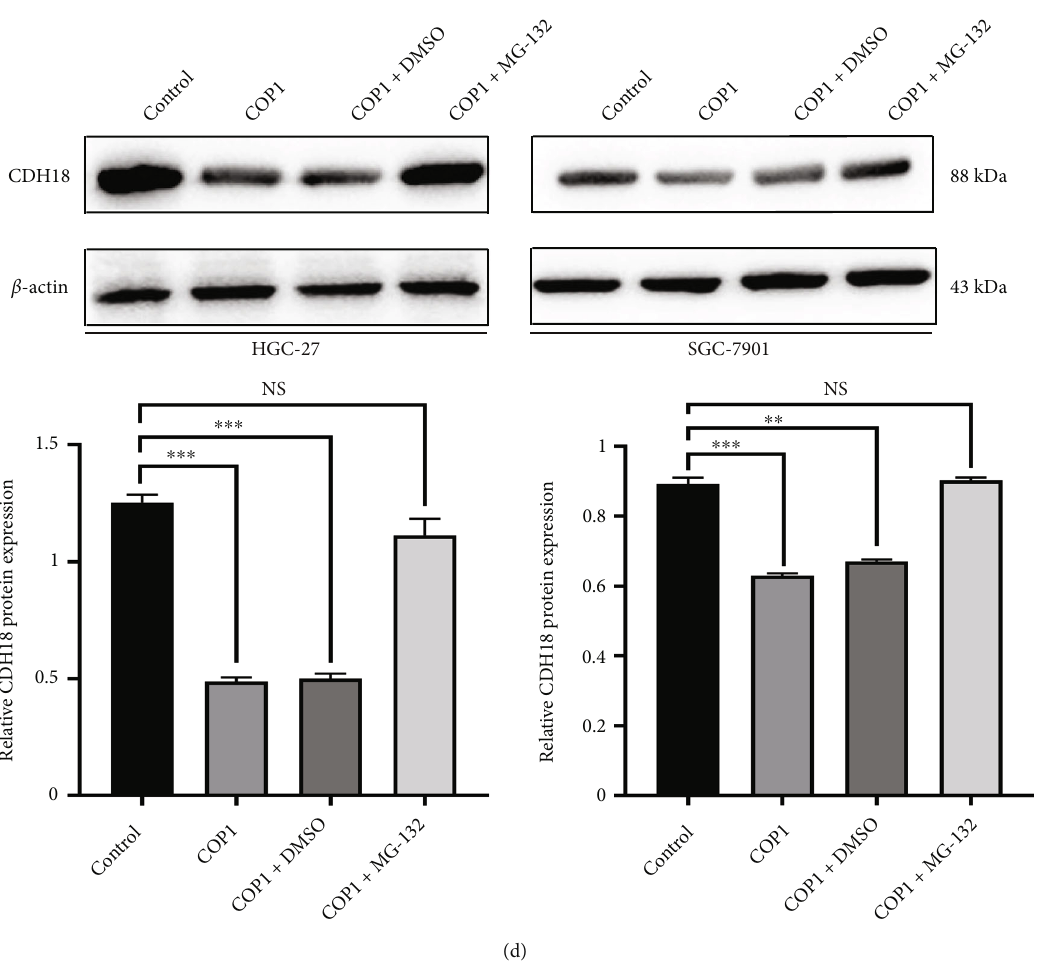
Figure 6: COP1 degraded CDH18 via the ubiquitin – proteasome pathway. (a) Sequence obtained from the yeast two-hybrid experiment was BLAST matched in NCBI database, and its matching degree to CDH18 reached 99%; (b) co-IP assay conducted in HEK-293T cells showed the possible bindings of COP1 and CDH18; (c and d) COP1 may degrade CDH18 via the ubiquitin – proteasome pathway. * P < 0 : 05 , ** P < 0 : 01 , *** P < 0 : 001